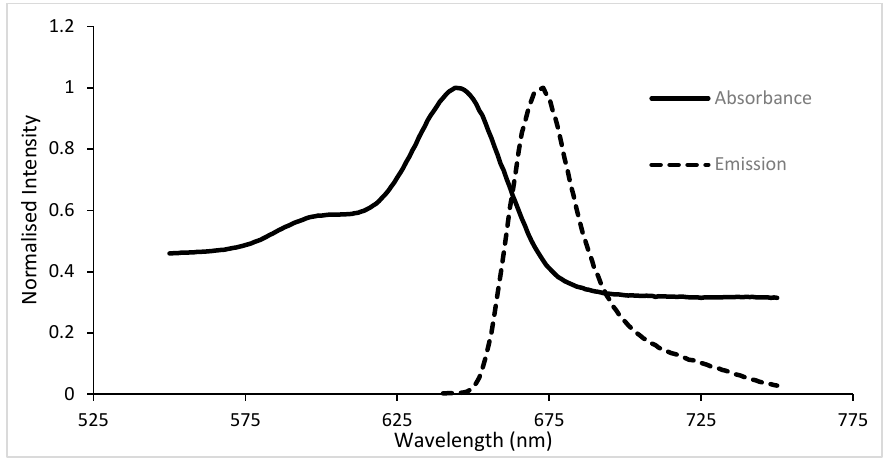
Figure 6. Absorbance and emission (relative to the maximum detected output) spectra of the AuNP suspension.